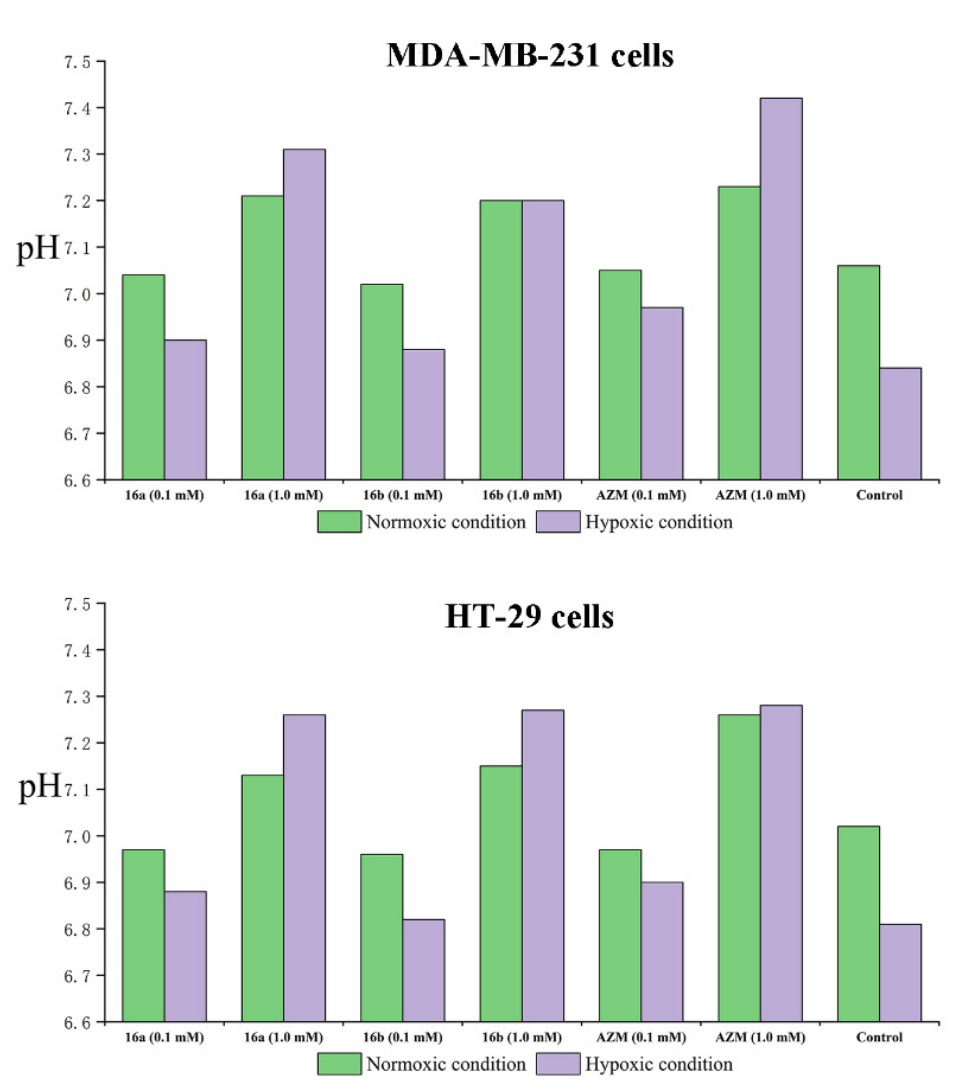
Figure 4. Extracellular pH measurement of MDA-MB-231 and HT-29 cells under normoxic and hypoxic conditions.